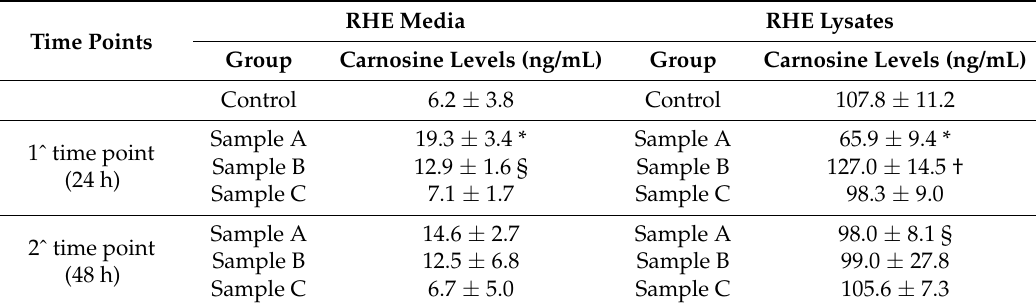
Figure 1. Carnosine levels in media from reconstructed human epidermis (RHE) tissues. Concentrations of carnosine released in media from RHE at 24 and 48 h after the topical application of different hydrogel formulations. A: Carnosine complex; B: Free carnosine; C: Magnesium salt in the same vehicle. Data are given as the means ± standard deviations (SD) of three separate experiments. * p < 0.05 versus control untreated RHE samples; § p < 0.05 versus sample A at 24 h. Table 2. Carnosine levels detected in media and lysates from RHE tissues treated with different gel formulations.